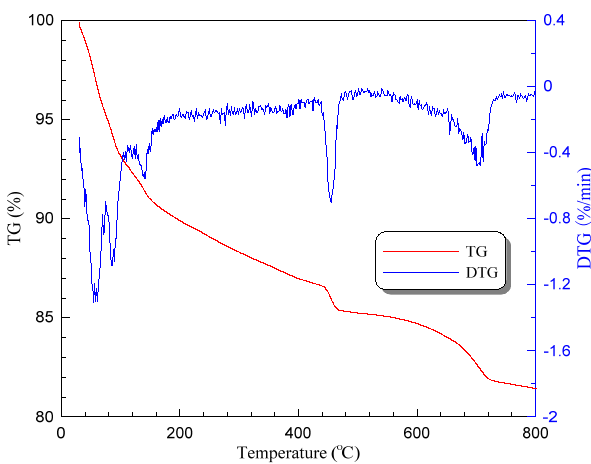
Figure 10. TG and DTG curves of PVA-ECC tested.